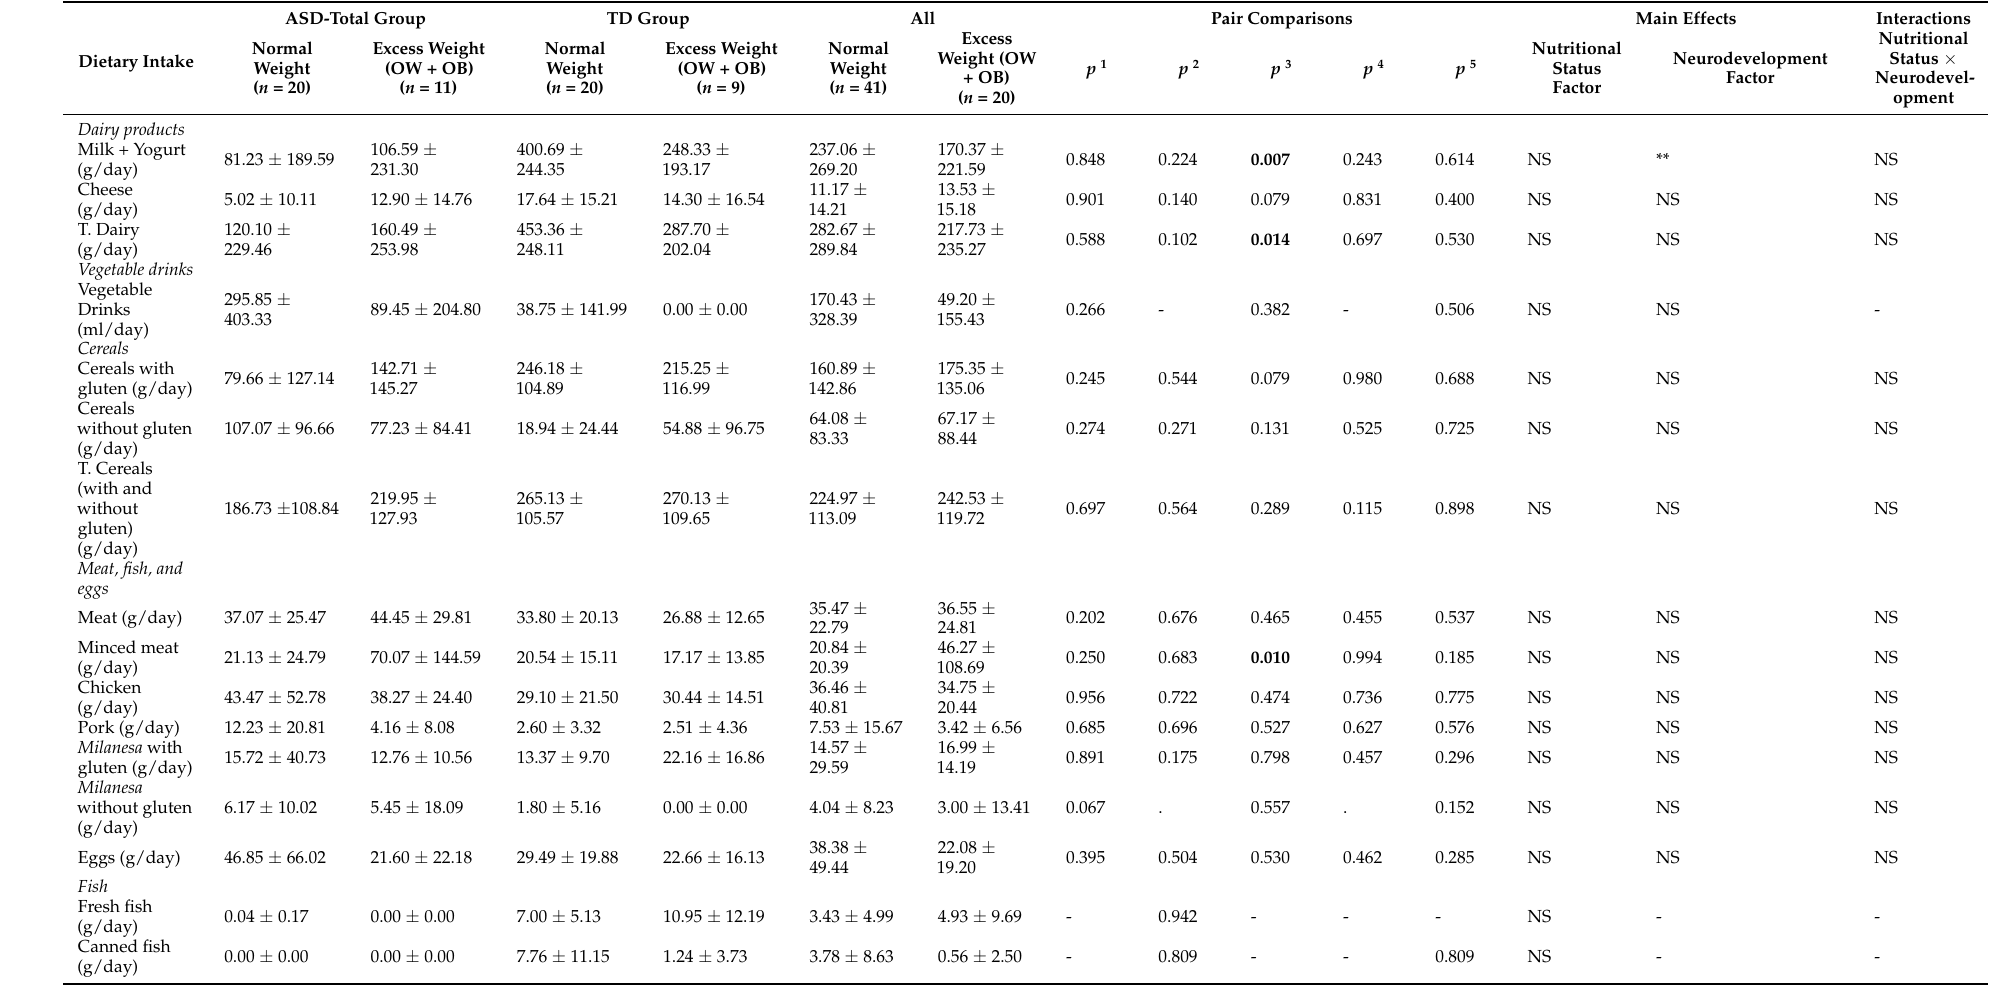
Table 3. Comparison of dietary intake between nutritional status groups (normal weight vs. excess weight) and neurodevelopment groups (autism spectrum disorder vs. typical development) by two-way